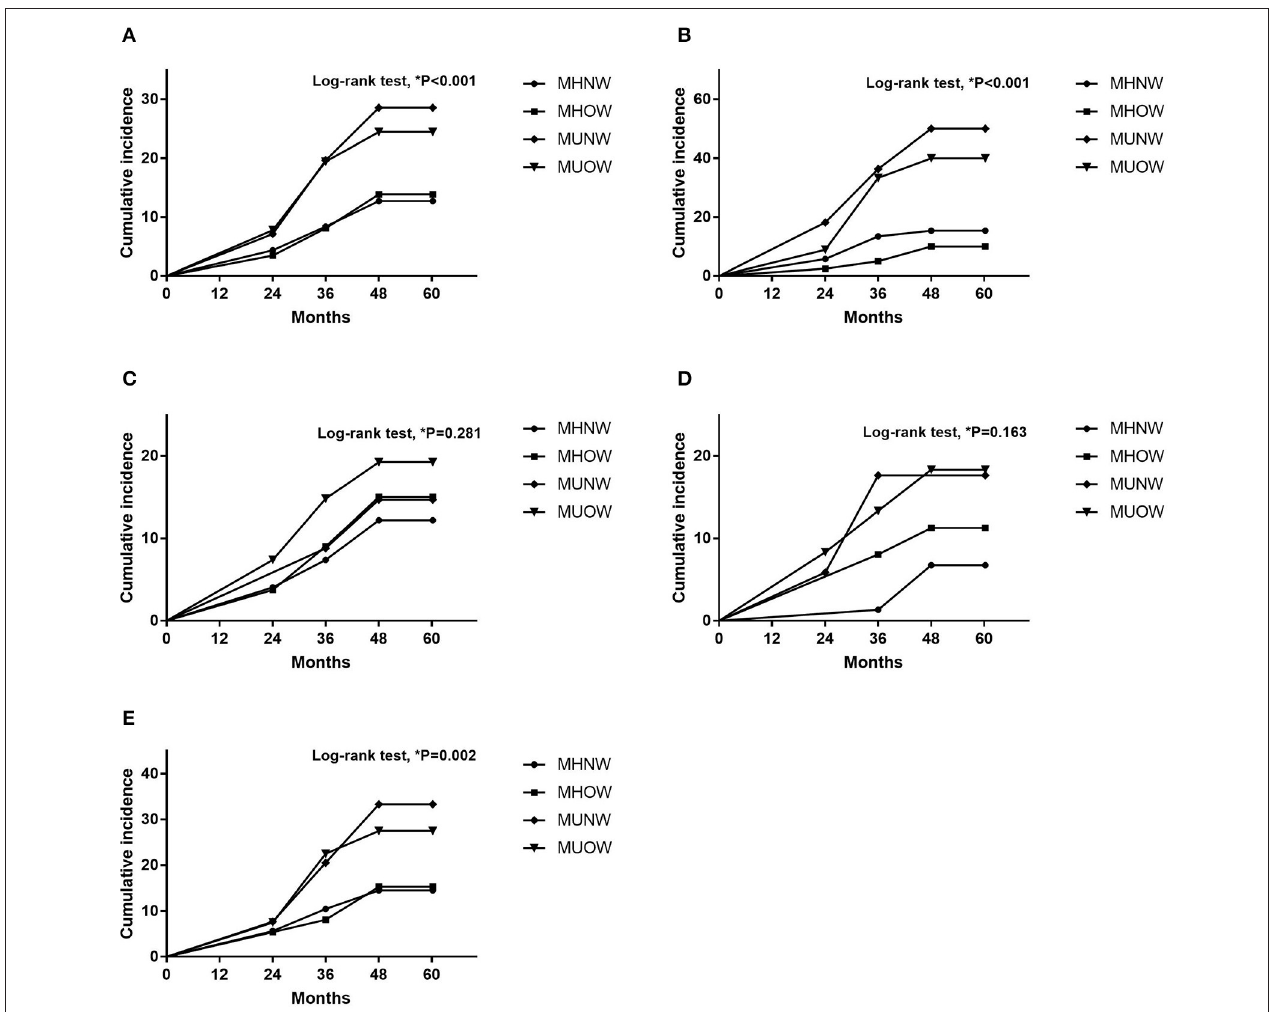
FIGURE 2 | Cumulative incidence according to MBCS (A) Overall population. (B) Participants ≥ 65 years old. (C) Participants < 65 years old. (D) Male participants. (E) Female participants. MBCS, metabolic body composition